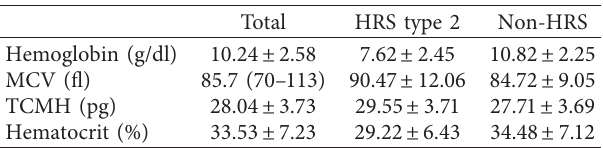
Table 2: Hematologic findings.